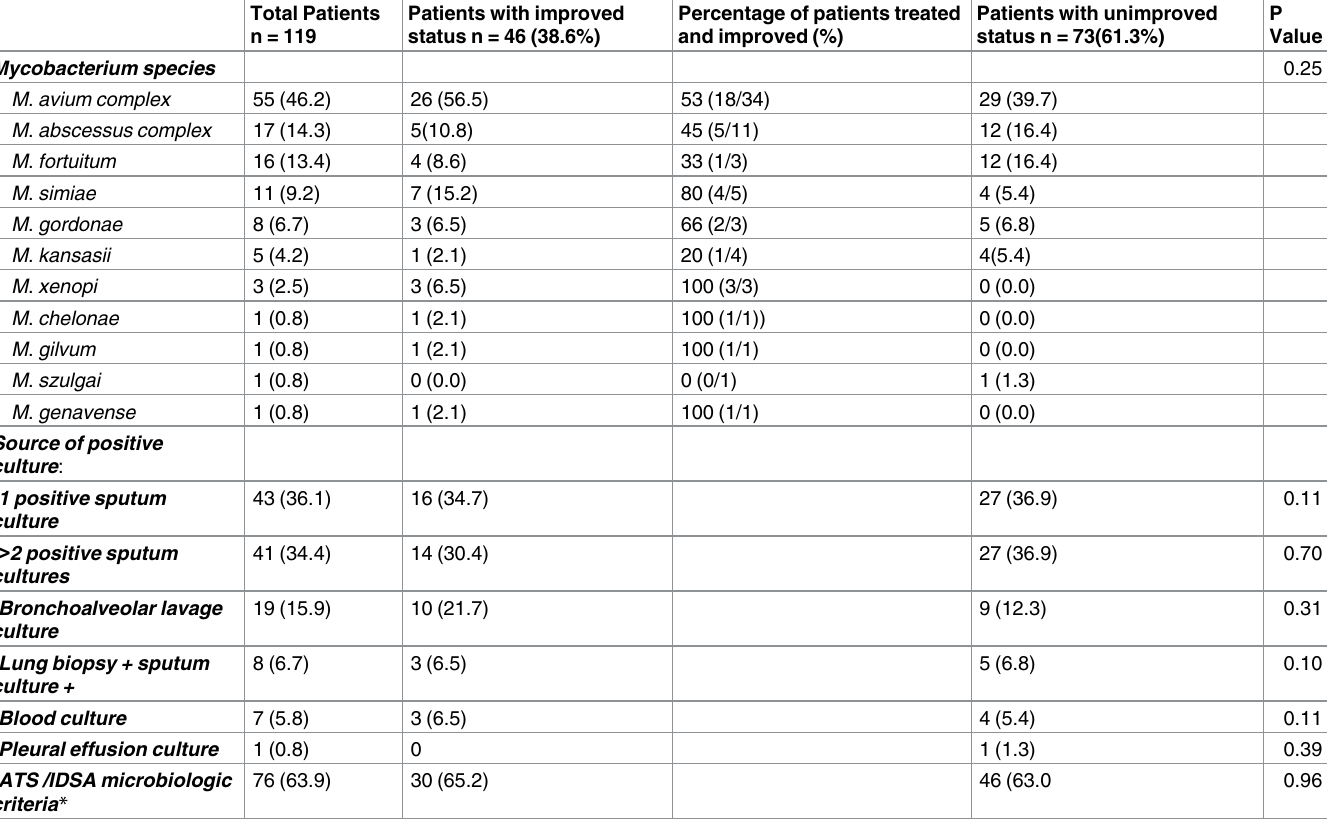
Table 3. Bacteriological characteristics of the